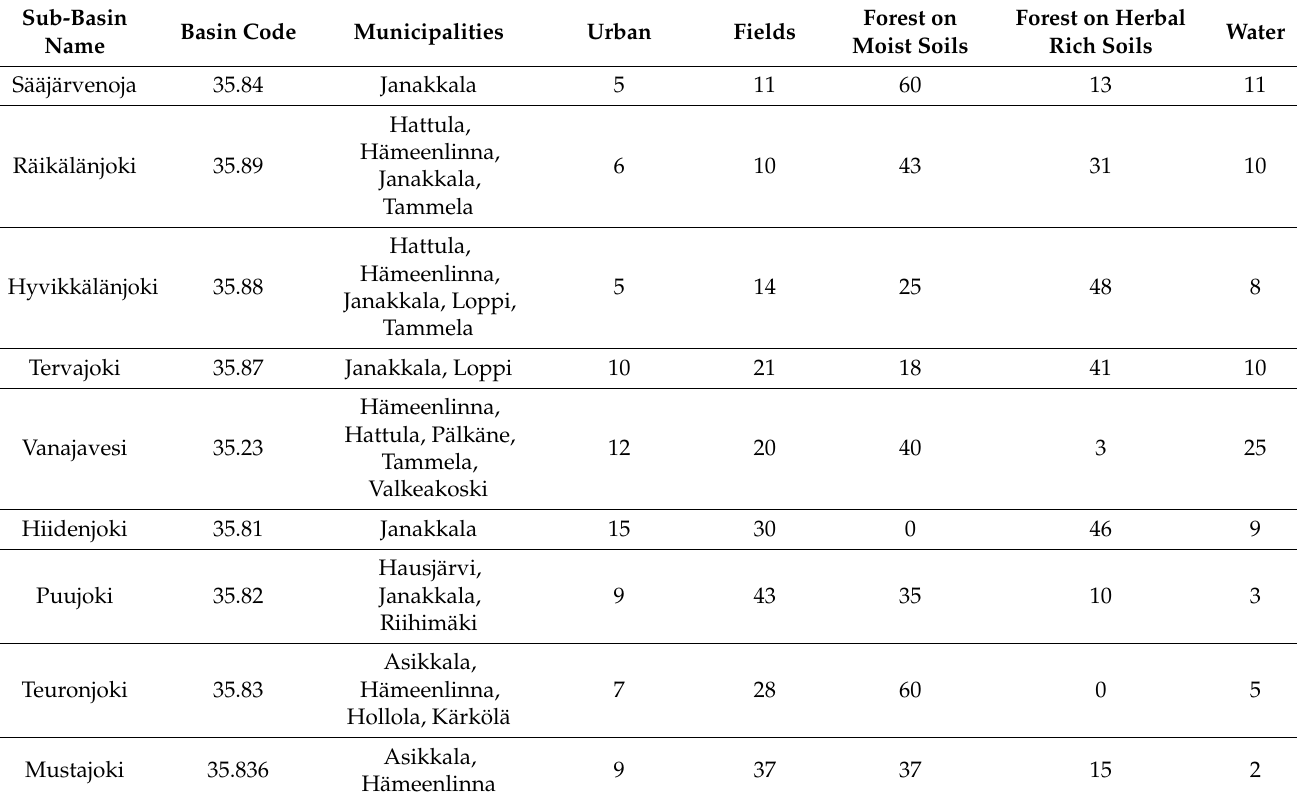
Table 1. Land cover (%) in the Vanajavesi